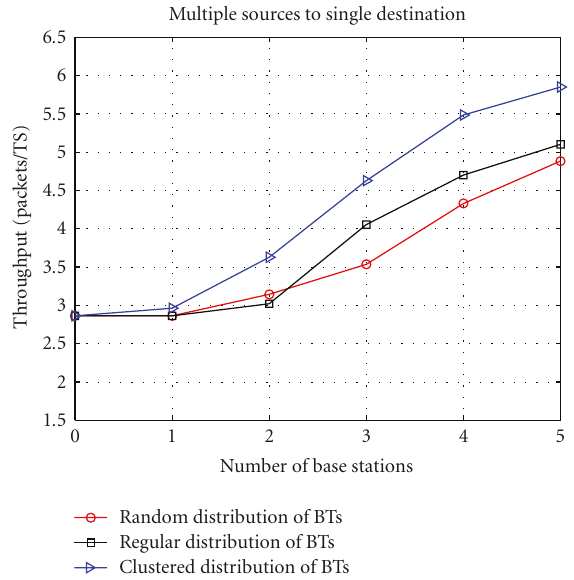
Figure 6: Throughput bound on di ff erent distribution patterns of multi-channel BTs.